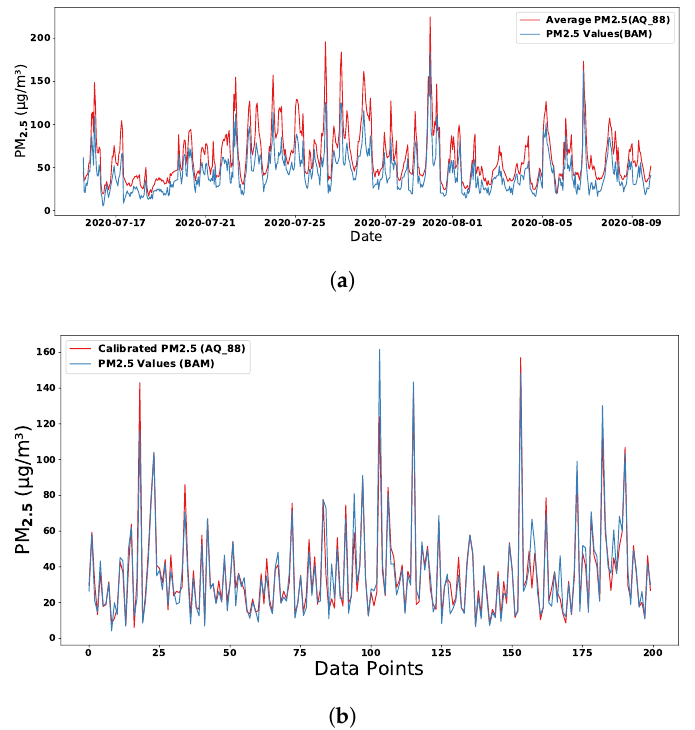
Figure 5. Calibration of low-cost air quality sensors using machine learning methods. ( a ) In-field comparison of AirQo low-cost sensors and reference grade before calibration. ( b ) PM 2.5 Calibrated low-cost sensor data vs reference grade monitor.